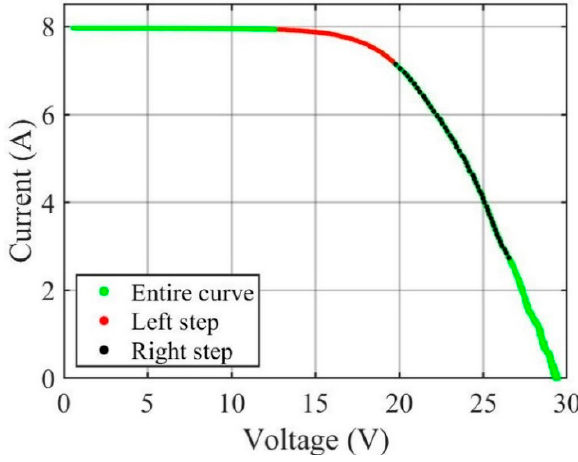
Figure 2. Measured P – U curve (green) jointly with cutting limits of 50% of P MPP on the left (red) and on the right (black) side of the MPP.